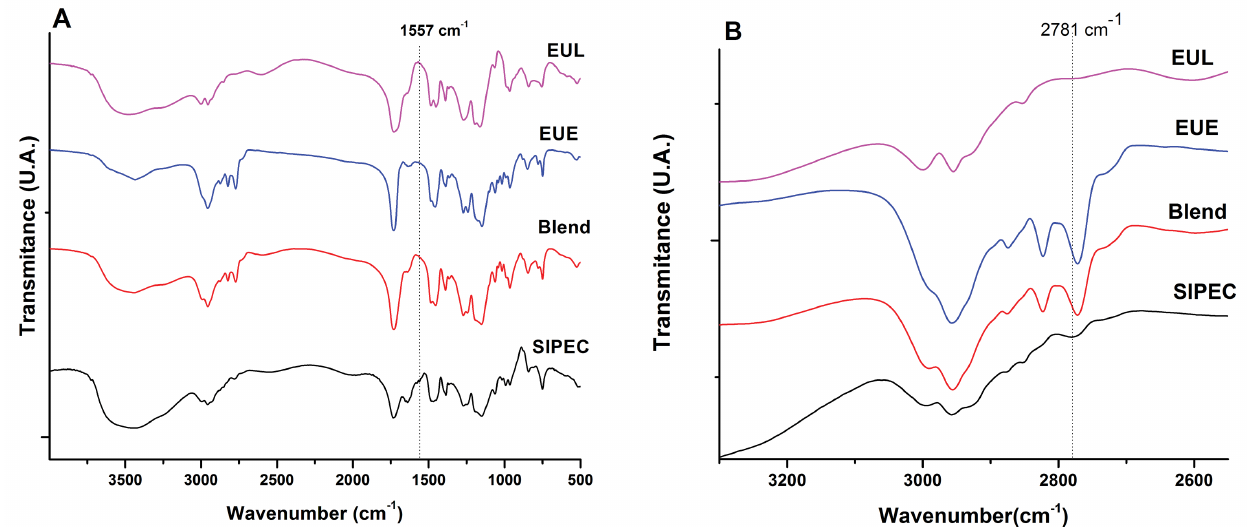
FIGURE 2 - A) Infrared spectra of the stoichiometric complex, a physical blend, and the individual components, and B) spectra zoom in the wavenumber range of 3300 cm −1 to 2650 cm −1